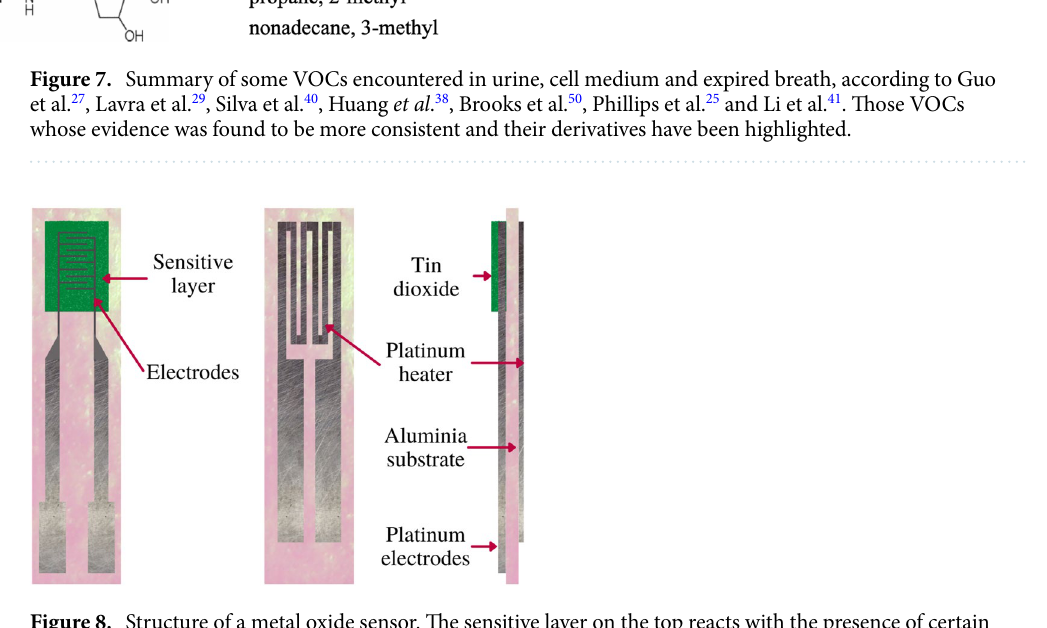
Figure 8. Structure of a metal oxide sensor. The sensitive layer on the top reacts with the presence of certain VOCs and thus sensors change in conductivity. The platinum heater placed on the bottom of the sensor consists of a dissipating resistance that outputs heat. By heating the sensor a higher VOC specificity is